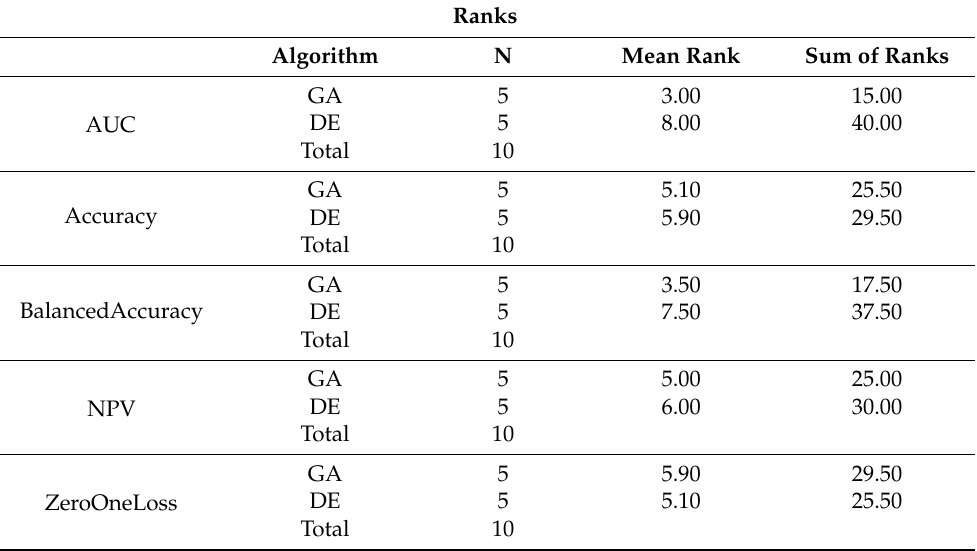
Table 2. Mann–Whitney U test